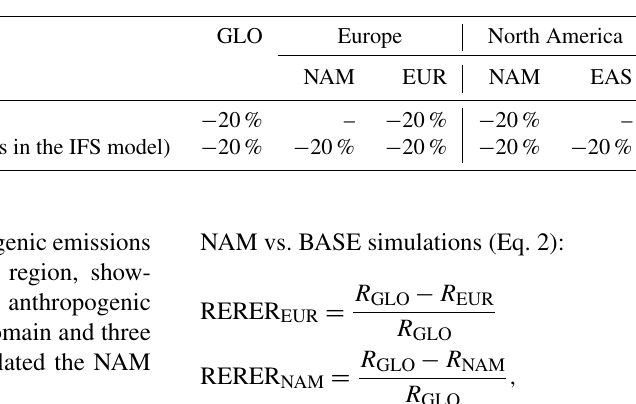
Table 2. Perturbations of global/regional anthropogenic emissions and boundary conditions in the perturbation scenarios.